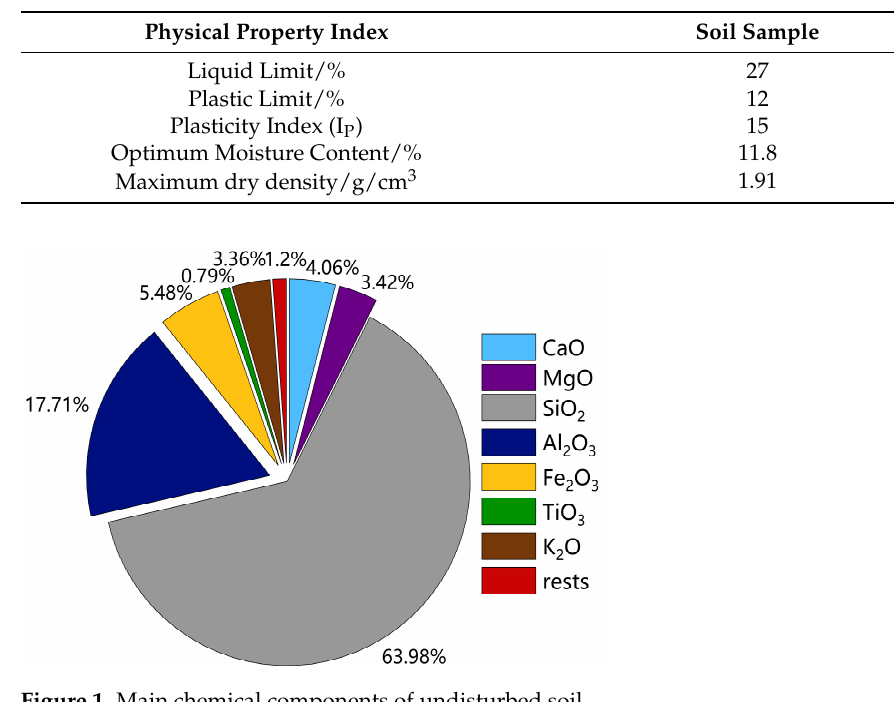
Table 1. Basic physical properties of undisturbed soil samples.